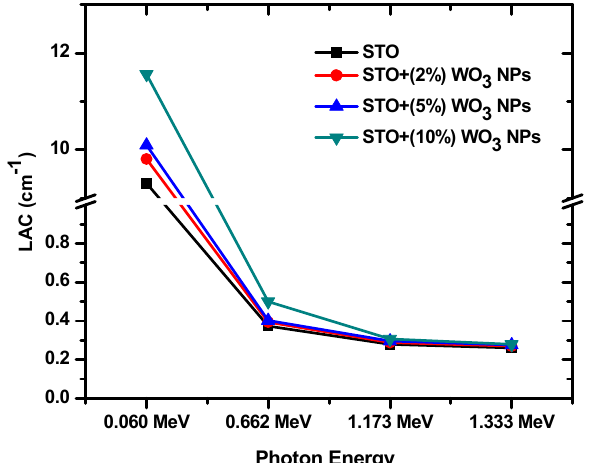
Figure 3. Mass attenuation coefficients of the STO ceramic and STO ceramic doped with x% of WO 3 NPs.